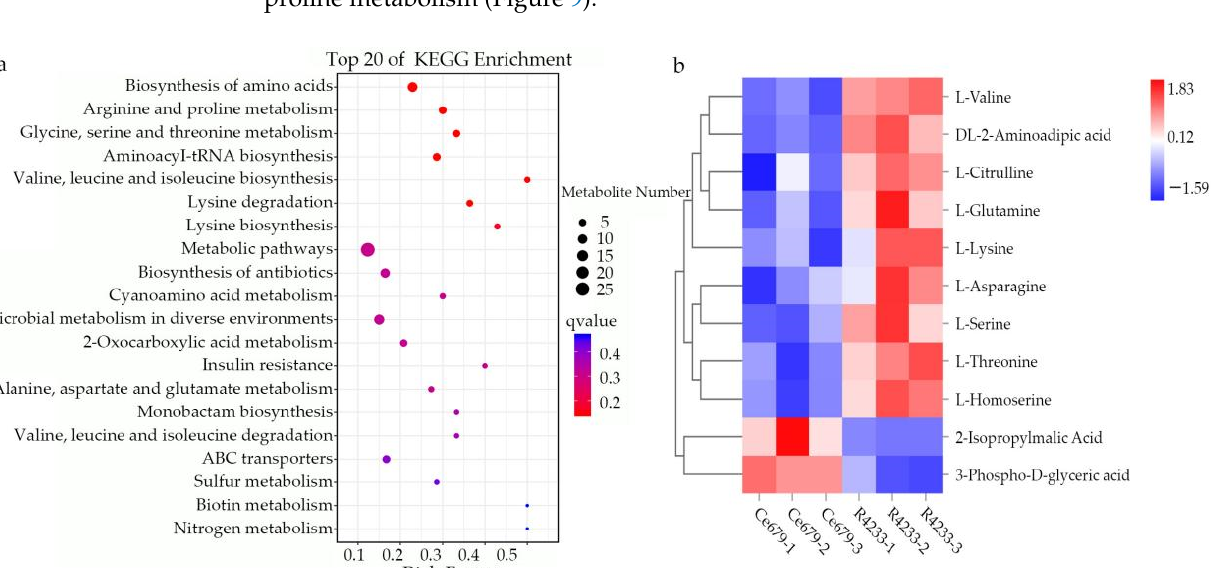
Figure 8. Identification of DEM and KEGG analysis. ( a ), DEMs of young panicle in Ce679 and R4233; ( b ), KEGG annotation of DEMs from young panicle in Ce679 and R4233. The DEM was significantly enriched in biosynthesis-related KEGG pathways, in- cluding the biosynthesis of amino acids, arginine, and proline metabolism ( p ≤ 0.05; Figure 9). The biosynthesis of amino acids was the most significantly enriched path- way. The L-Serine, L-Valine, L-Threonine, L-Homoserine, L-Asparagine, L-Glutamine, L-Lysine, DL-2-Aminoadipic acid, L-Citrulline, 2-Isopropylmalic Acid, and 3-Phospho- D-glyceric acid metabolites were found to be related to the biosynthesis of amino acids; however, γ -Aminobutyric acid, 4-Guanidinobutanal, N-Acetylputrescine, Agmatine, 4- Acetamidobutyric acid, and 4-Guanidinobutyric acid were related to the arginine and proline metabolism (Figure 9).